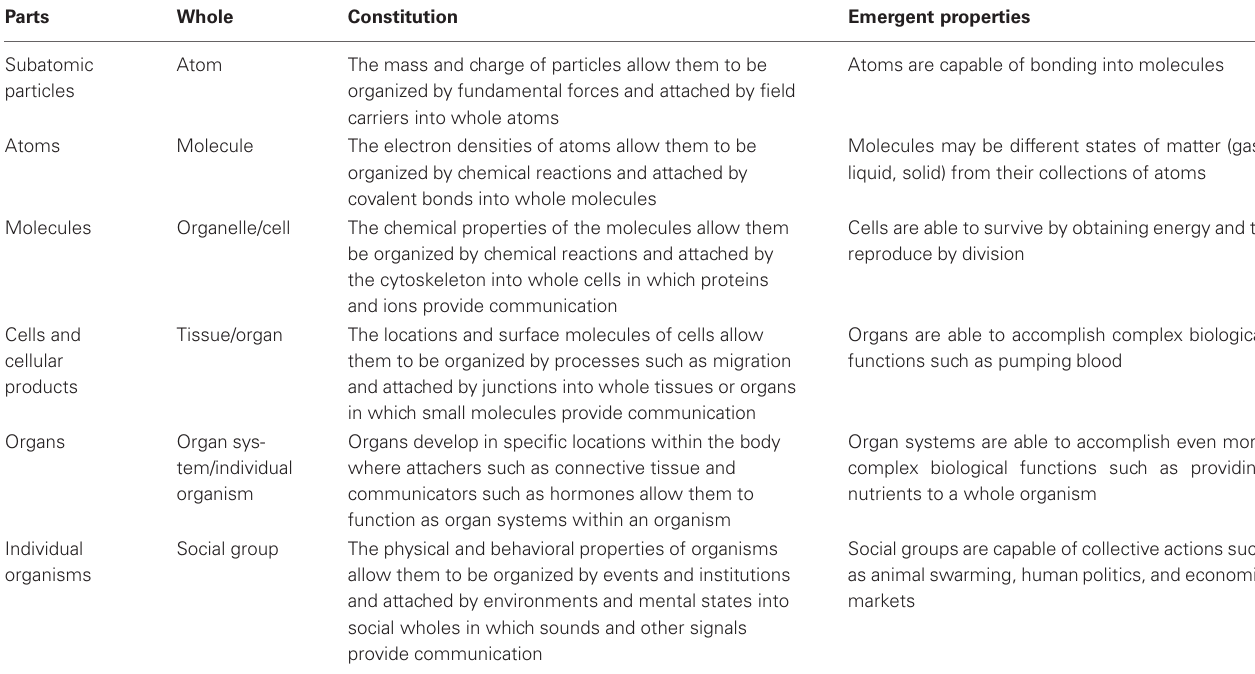
Table 2 | Examples of constitution and